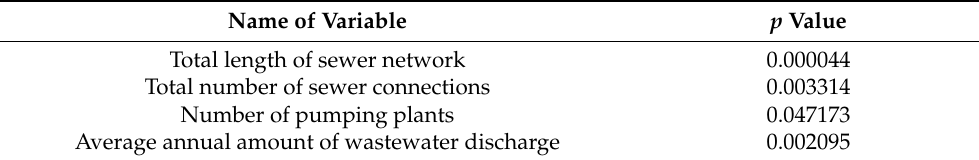
Table 6. Statistically significant independent variables for maintenance cost estimation